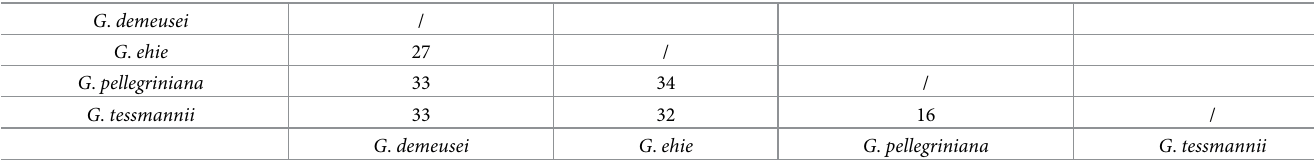
Table 8. SNP variation in the ETS region among Guibourtia species.